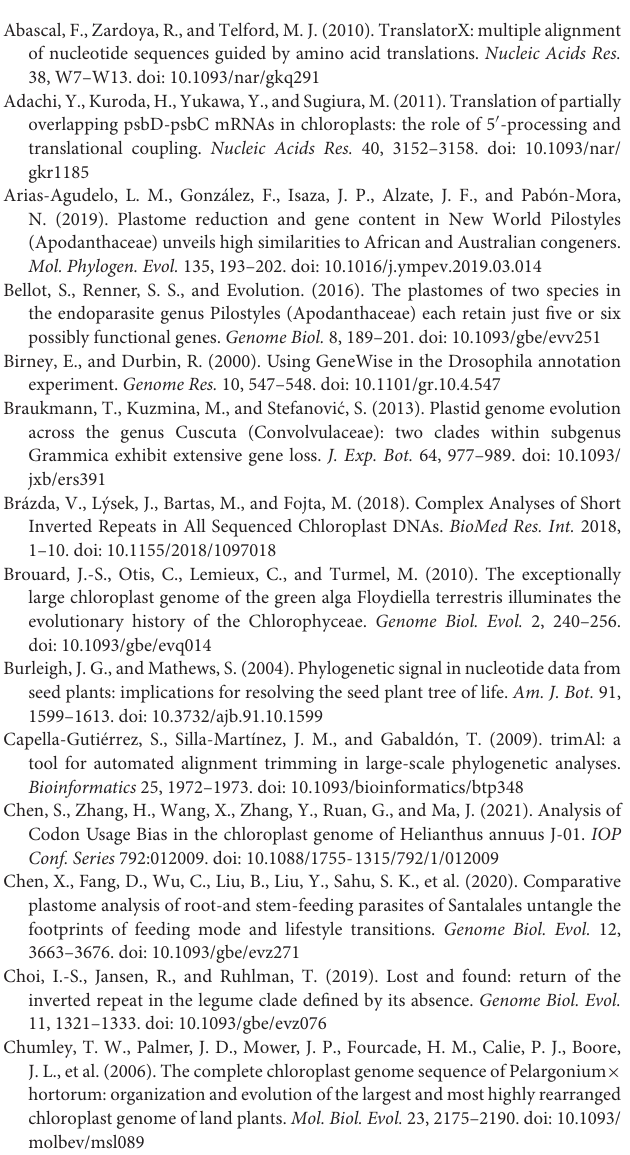
IQTREE. The colors on the internal circle indicate different families while the colors on the external circle indicate different orders. Supplementary Figure 6 | Chloroplast phylogenomic tree based on the matrix nt12 of 72 protein-coding genes of 3,654 green plants using RaXML. The colors on the internal circle indicate different families while the colors on the external circle indicate different orders. Supplementary Figure 7 | Chloroplast phylogenomic tree based on the matrix nt123 of 72 protein-coding genes of 3,654 green plants using RaXML. The colors in the internal circle indicate different families while the colors in the external circle indicate different orders. Supplementary Figure 8 | Chloroplast phylogenomic tree based on the matrix aa of 72 protein-coding genes of 3,654 green plants and 1,901 species in the former research using IQTREE. The colors on the internal circle indicate different families while the colors on the external circle indicate different orders.